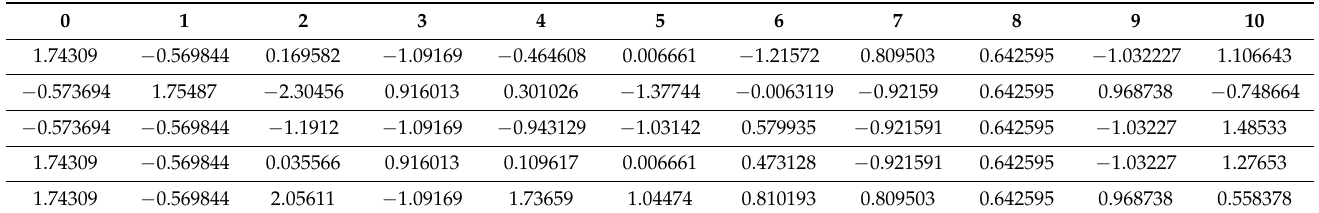
Table 3. Normalized